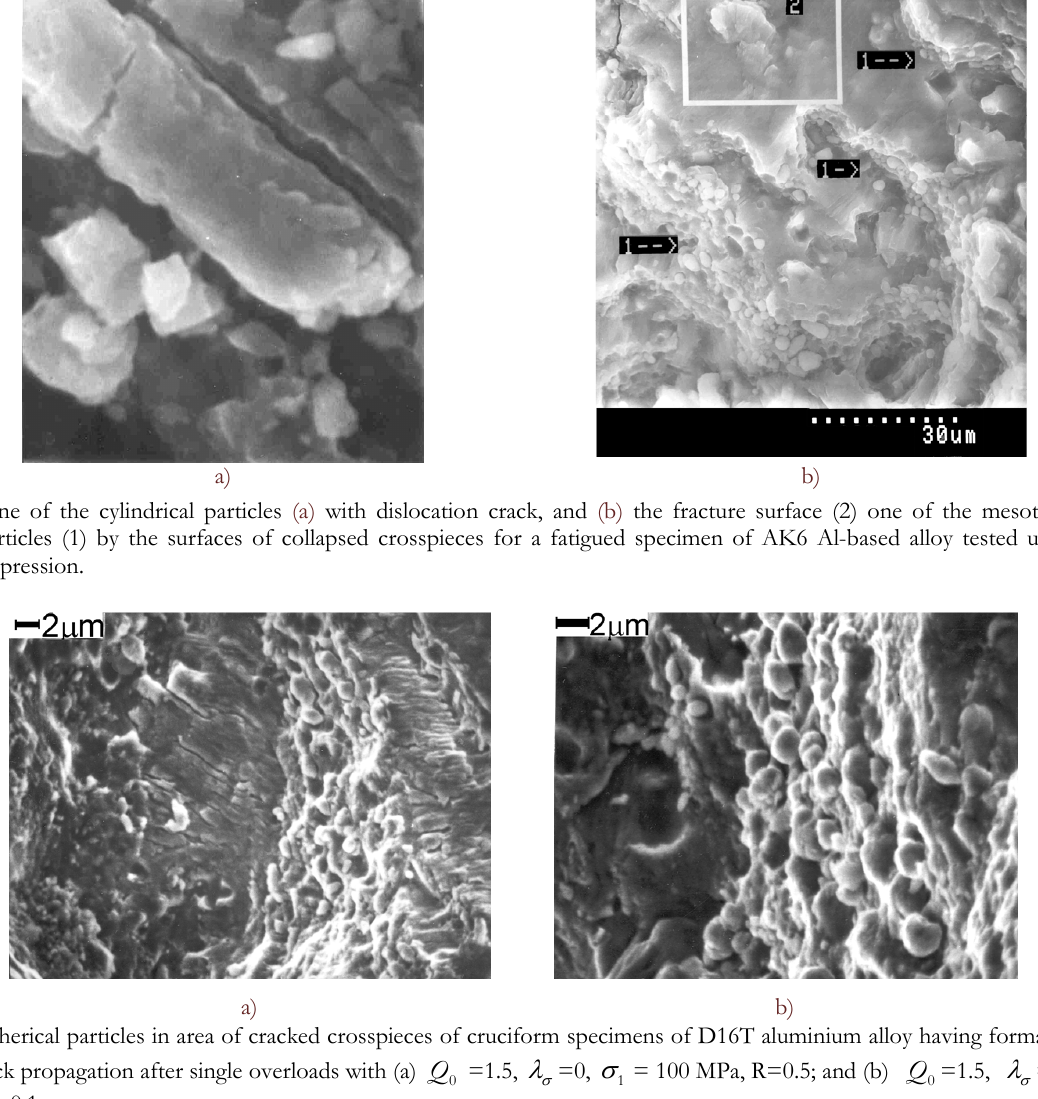
 =0,  Q =1.5, = 100 MPa, R=0.5; and (b)  0 1